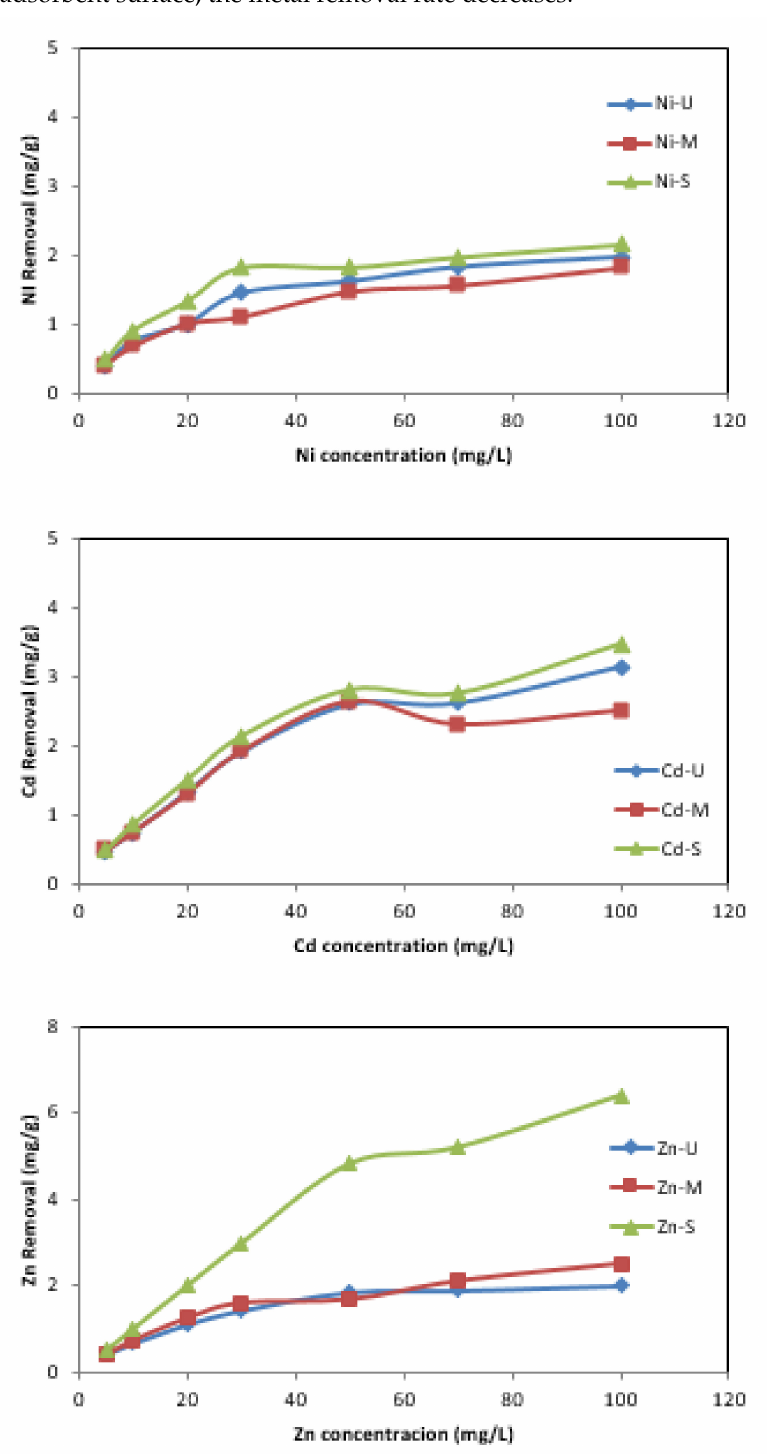
Figure 12. Effect of initial concentration versus mg/g of metal removal. (Co = 5–100 mg/L, adsor- bent = 0.25 g, t = 24